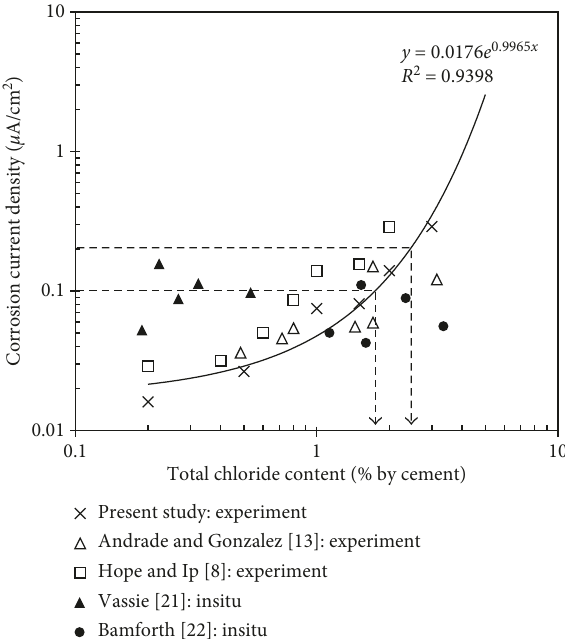
Figure 4: Changes in corrosion current density of the specimen with chloride in cast.